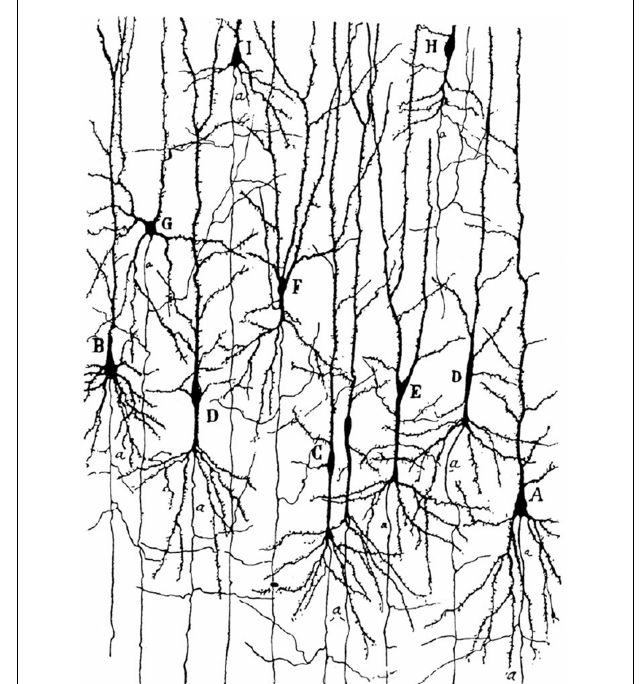
FIGURE 1 | Golgi staining of the FI in a 1-month-old human girl. Note the von Economo neurons (VENs) marked by the letters C and D, and the very distant axon origin of these cells. Image acquired from Cajal